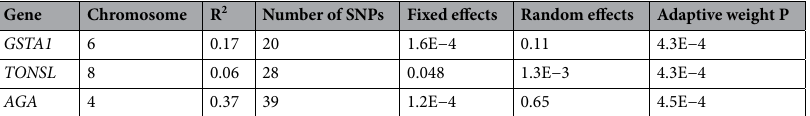
Gene Chromosome R 2